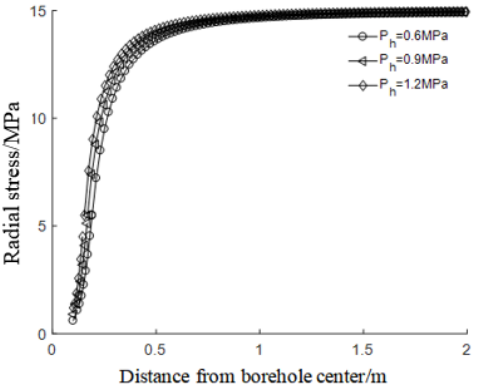
Figure 7. Variation in radial stress around borehole under different fracturing pressures.